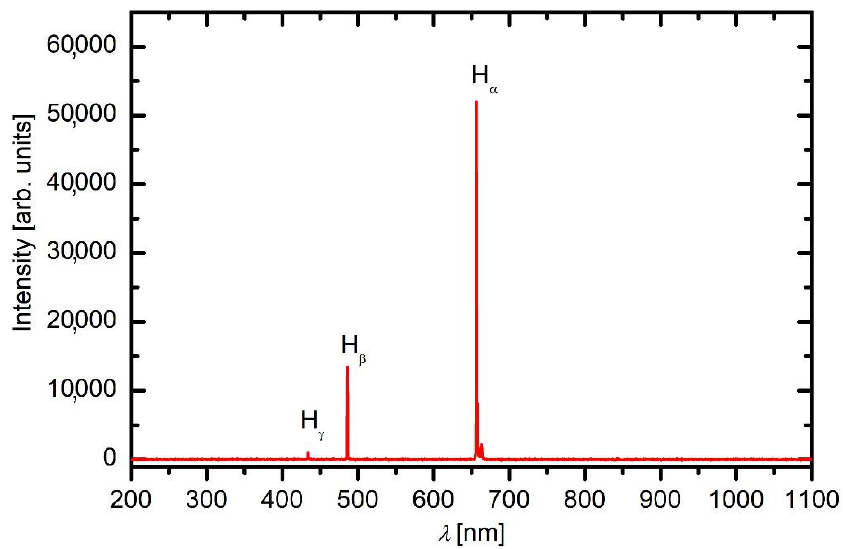
Figure 1. The optical spectrum during the treatment of PTFE with hydrogen plasma.